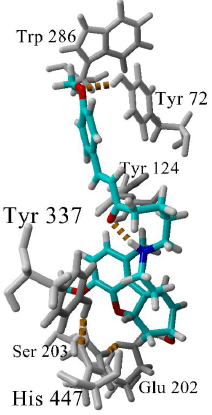
Figure 7. Hydrogen bonds (in yellow dashes) in the complex 4b -AChE. Most of the time, the GAL’s ammonium group makes a hydrogen bond with Tyr337. At the given snapshot (45 ns), the N-atom makes an intramolecular hydrogen bond with the linker carbonyl oxygen. A second hydrogen bond is formed between the methoxyphenyl O-atom and Tyr72. The latter bond determines the higher affinity of 4b to AChE.